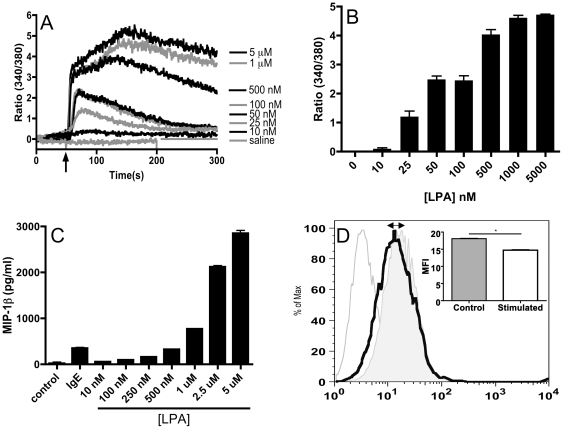
Functional responses in LAD2 induced by LPA.(A) Changes in intracellular calcium levels were determined using FURA-2AM loaded LAD2 cells (1×106 cell/sample) exposed to a range of concentrations of LPA (N = 2 independent experiments). (B) Maximal calcium flux in (A) represented in bar graph form; N = 2, mean± SEM. (C) Dose-dependent release of MIP-1β from LAD2 stimulated for 6 hours with IgE-crosslinking or the indicated concentrations of LPA (N = 3 independent experiments). Mean ± SD. (D) LPA5 internalization in response to 1 mM LPA measured 15 min post stimulation determined by flow cytometric analysis. Filled grey tracing represents unperturbed cells whereas black tracing depicts LPA-stimulated cells (representative of three experiments). The quantified reduction in MFI is shown in inset (Mean ± SD, N = 5, *P<0.0001).